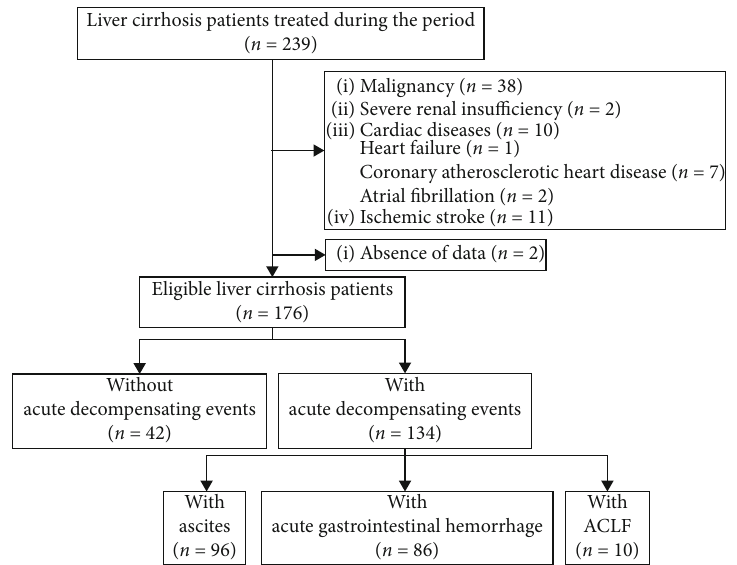
Figure 1: A fl ow chart of patient